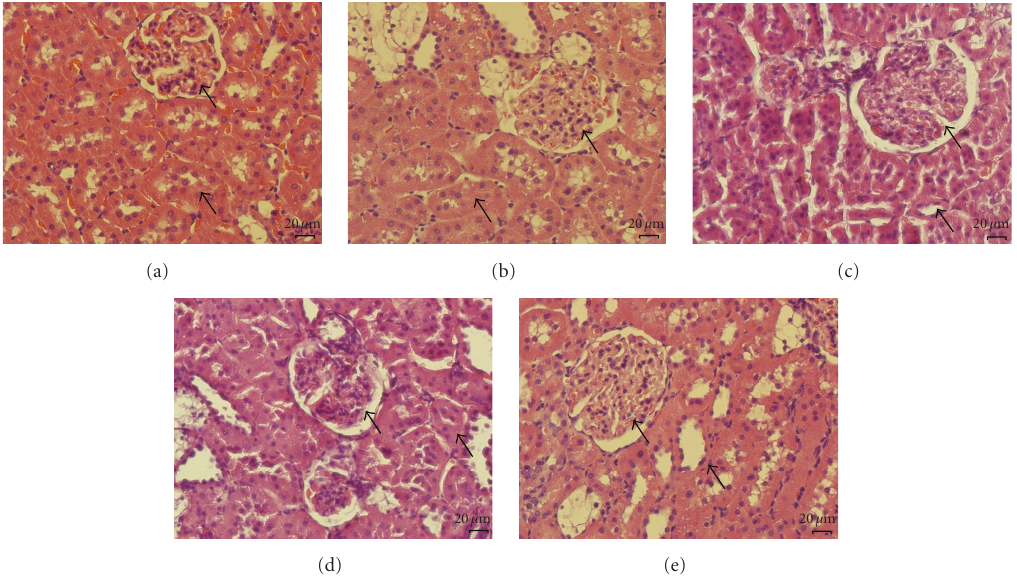
Figure 1: Kidney sections of STZ rat treatmented with isulin, phlorizin, and tiron. Histology of kidneys were characterized by staining with hematoxylin-eosin staining (Magnification: 400x). (a) normal wistar, (b) STZ rats, (c) insulin treated STZ rats, (d) phlorizin-treated STZ rats, and (e) tiron-treated STZ